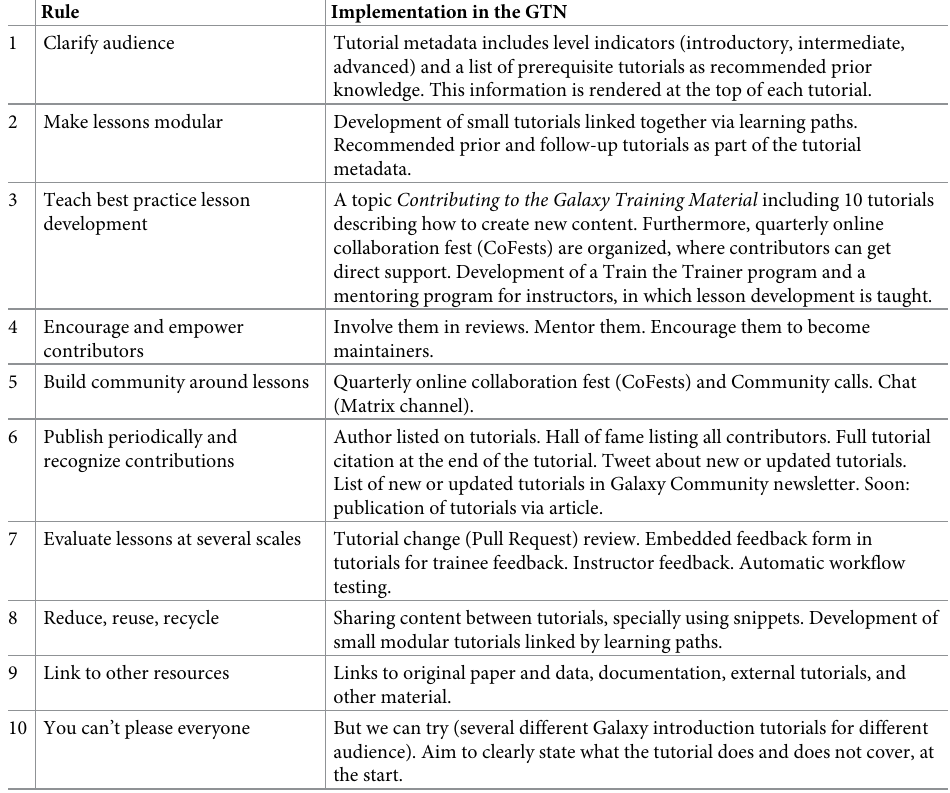
Table 2. Implementation of the “Ten simple rules for collaborative lesson development” [29] in the GTN.